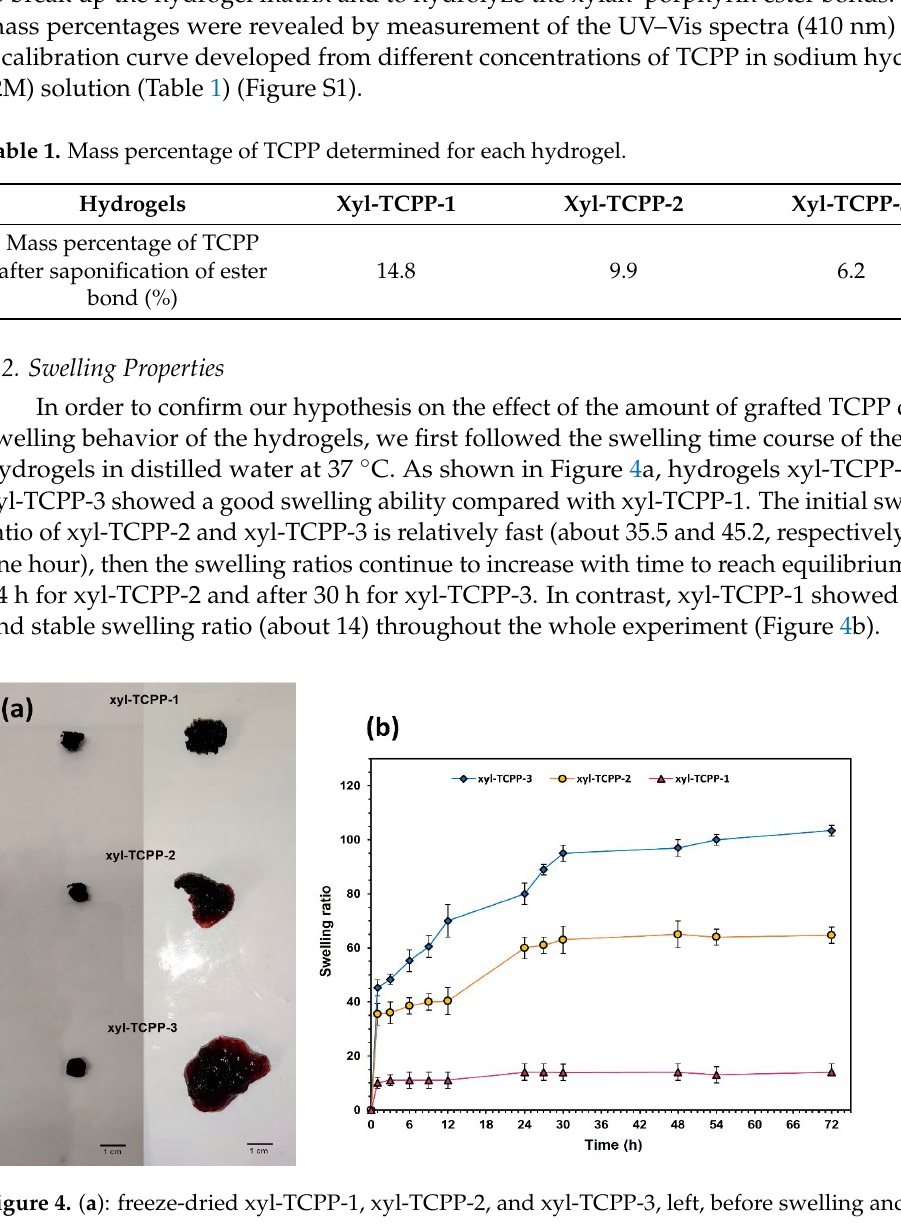
Table 1. Mass percentage of TCPP determined for each hydrogel.